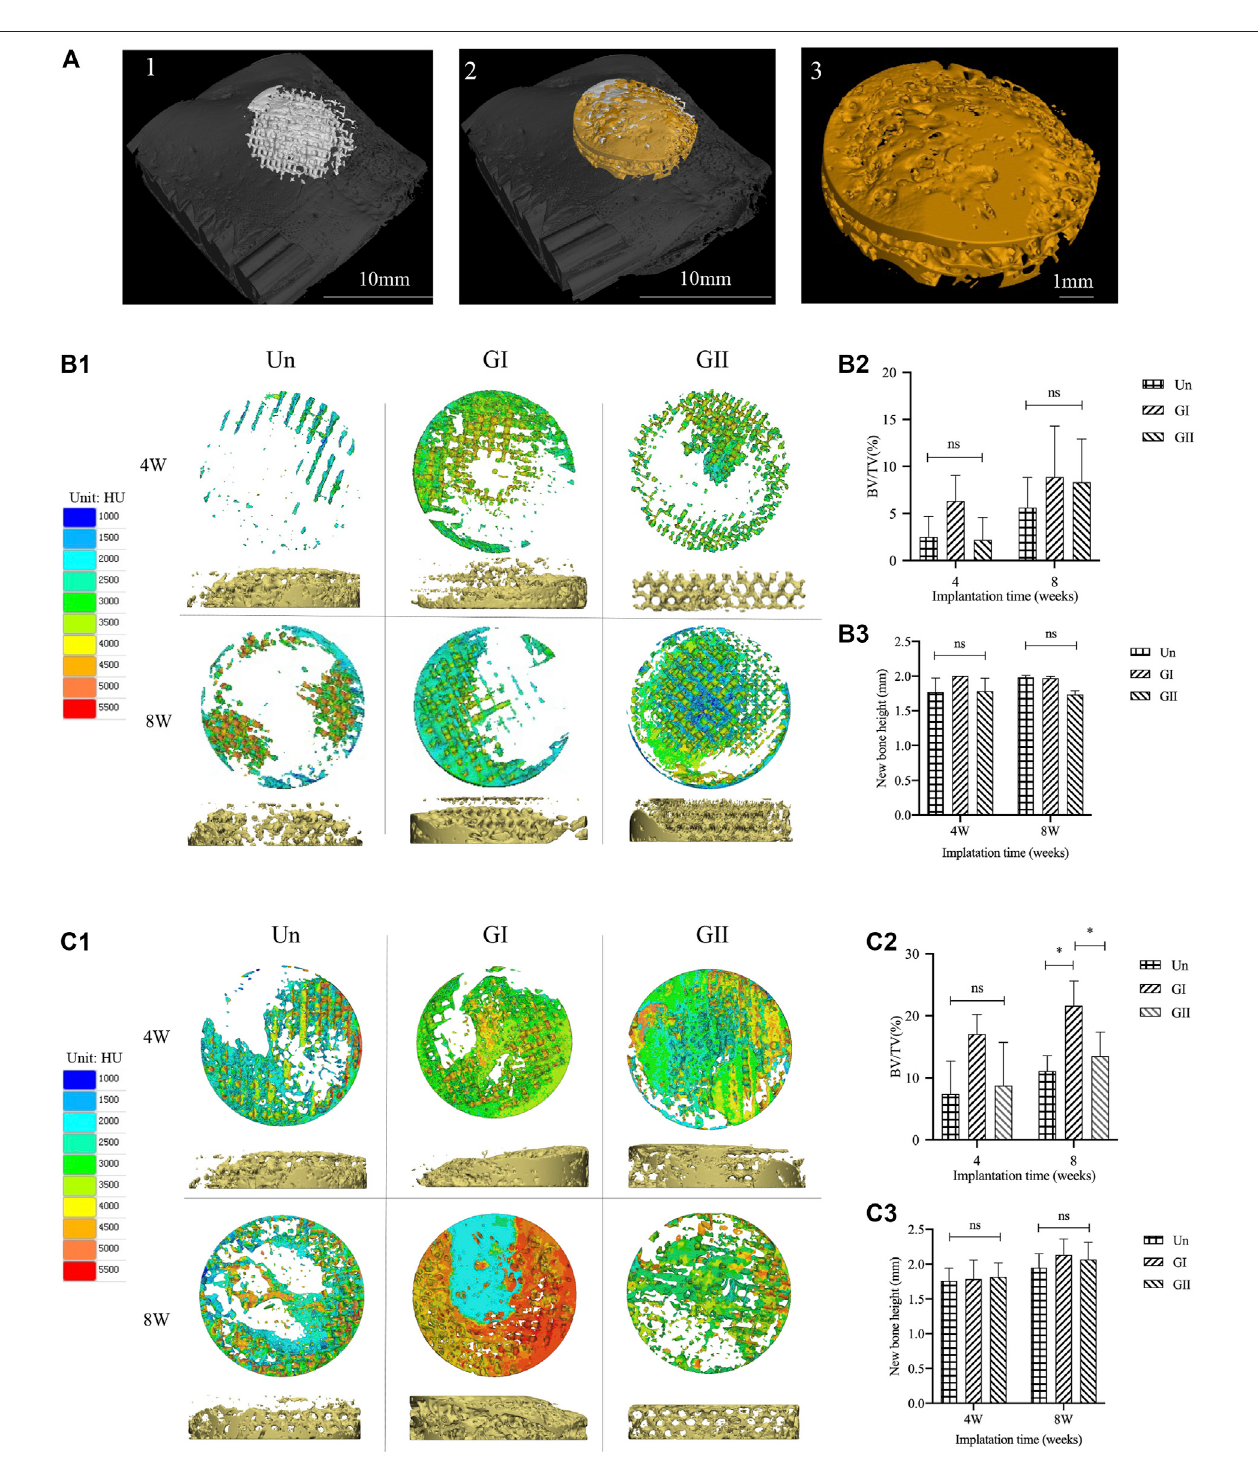
FIGURE 6 | Micro-CT analysis of animal experiments. (A) The new bone was extracted. (B1) The density distribution of new bone in the rats. (B2) BV/TV of rats. (B3) Theheight ofthenew bone inrats. (C1) The density distributionvaries ofnew bone inthe rabbits. (C2) BV/TV ofrabbits. (C3) Theheight ofthenew bone in rabbits.